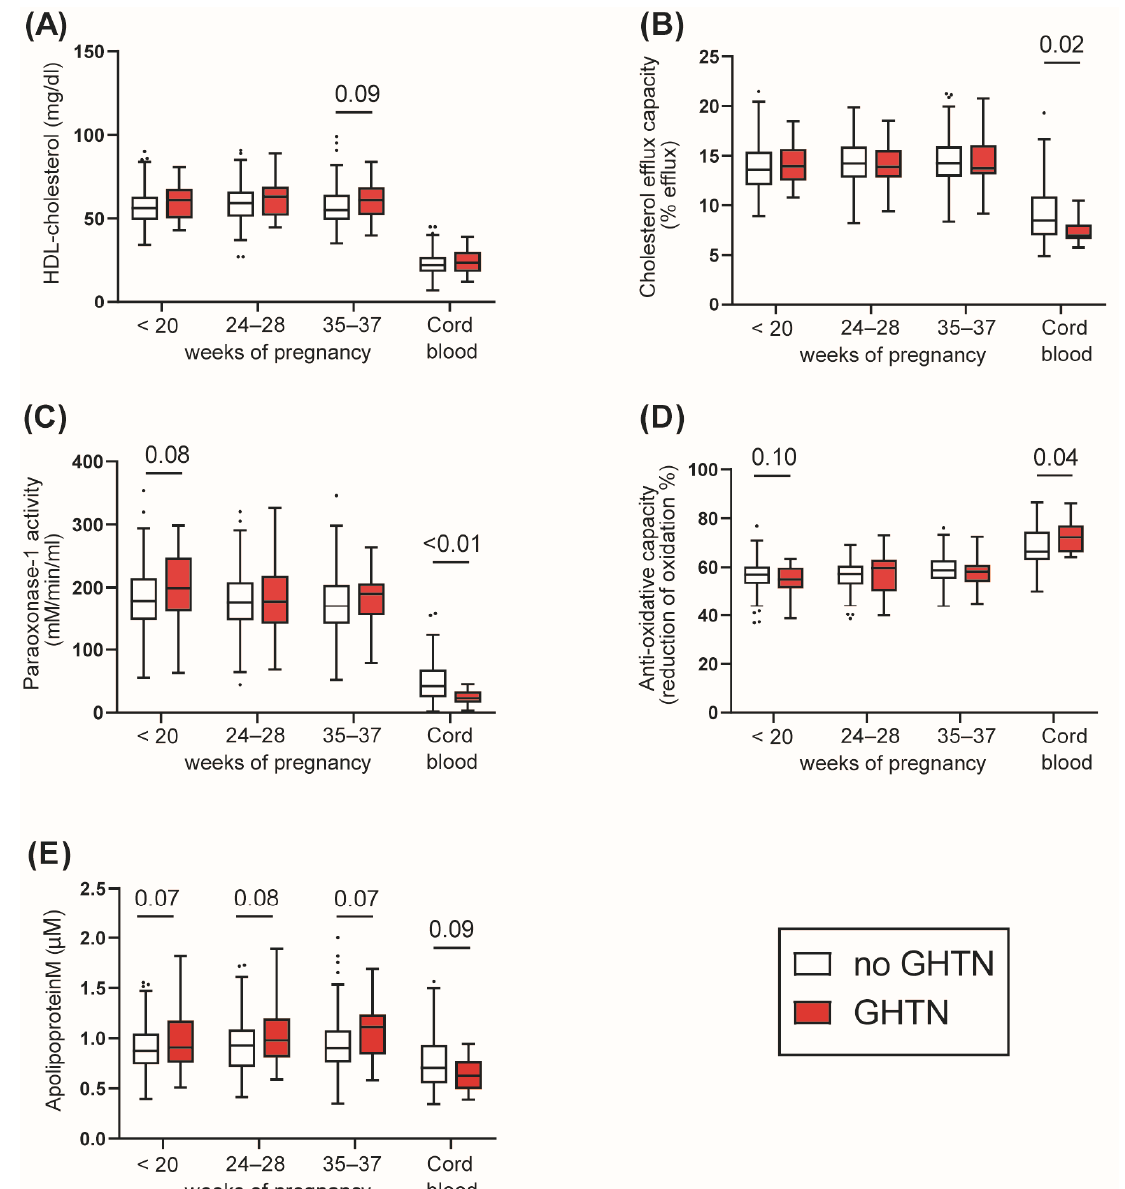
Figure 2. Differences in HDL-related parameters in women with GHTN and healthy controls. HDL- cholesterol ( A ), cholesterol efflux capacity ( B ) and the activity of HDL-associated PON1 ( C ) were assessed. ( D ) Serum anti-oxidative capacity and ( E ) apolipoprotein M levels. Data are presented as Tukey-Boxplots showing the median and interquartile ranges as well as minimum, maximum values and outliers. Significant ( p < 0.05) and non-significant trends ( p < 0.10) are indicated with p -value. Differences were analysed by student T -test (maternal samples) or Mann–Whitney U test (cord blood).